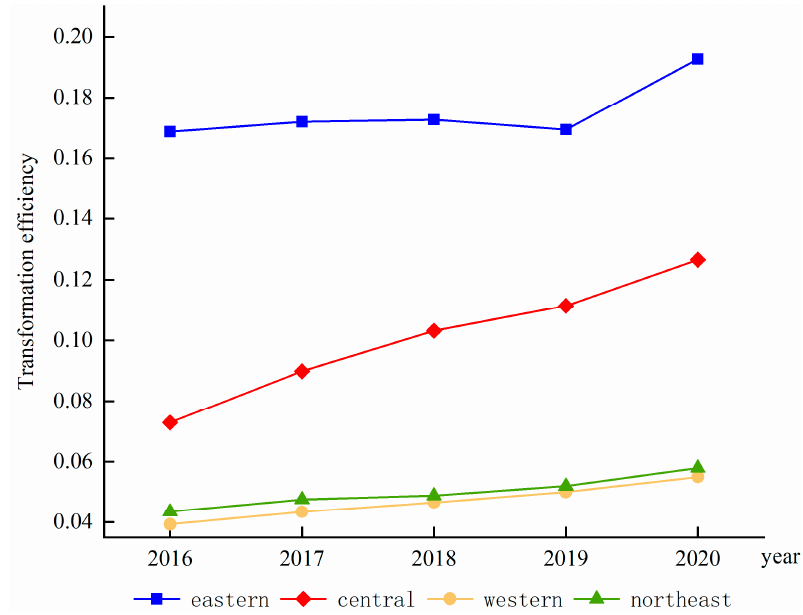
Figure 2. Manufacturing transformation efficiency trends in four major regions.